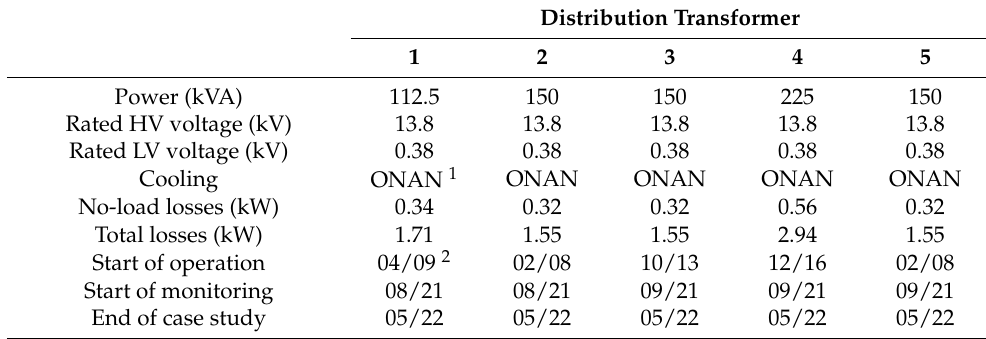
Table 3. Main construction and operational data of the distribution transformers in the case study. Distribution